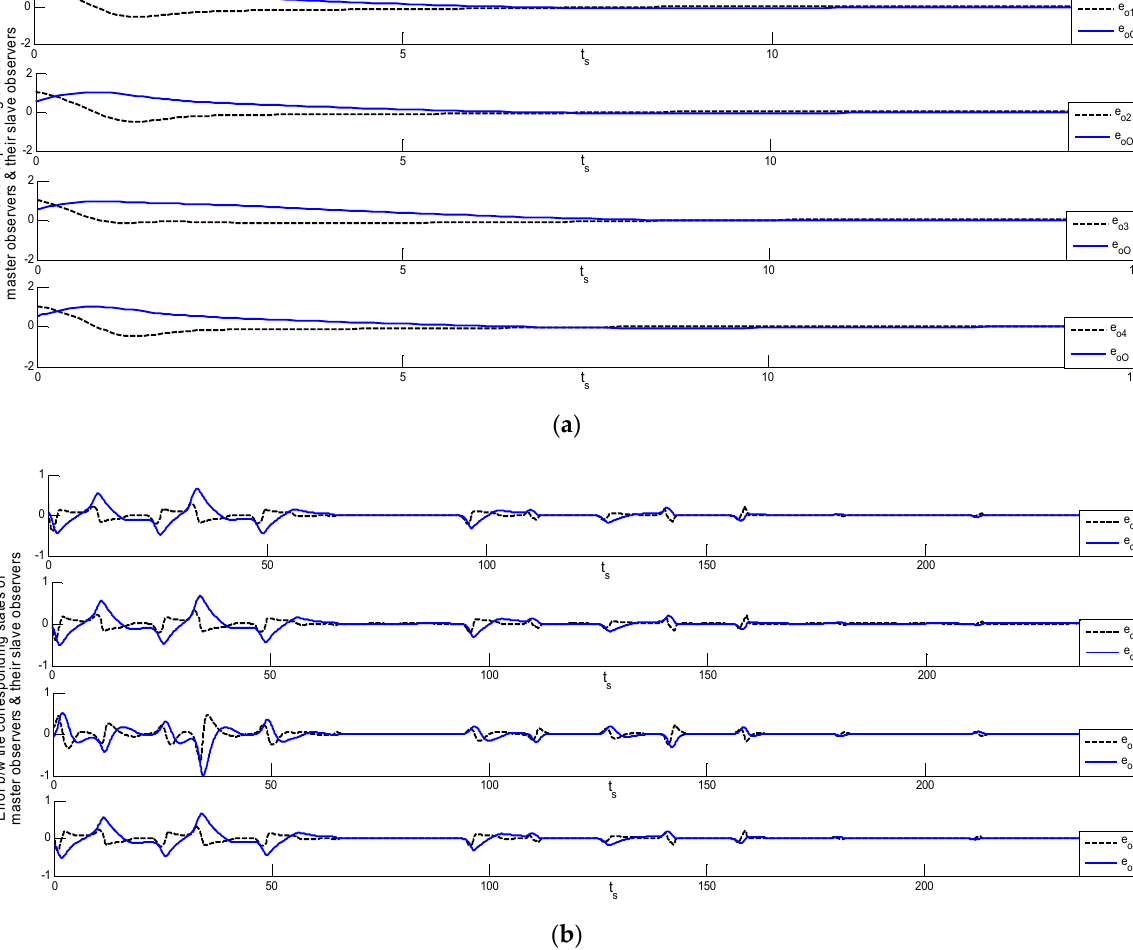
Figure 7. ( a ) Errors between the master observers’ states; ( b ) corresponding to the four states of slave observers (X M -X SI ) of